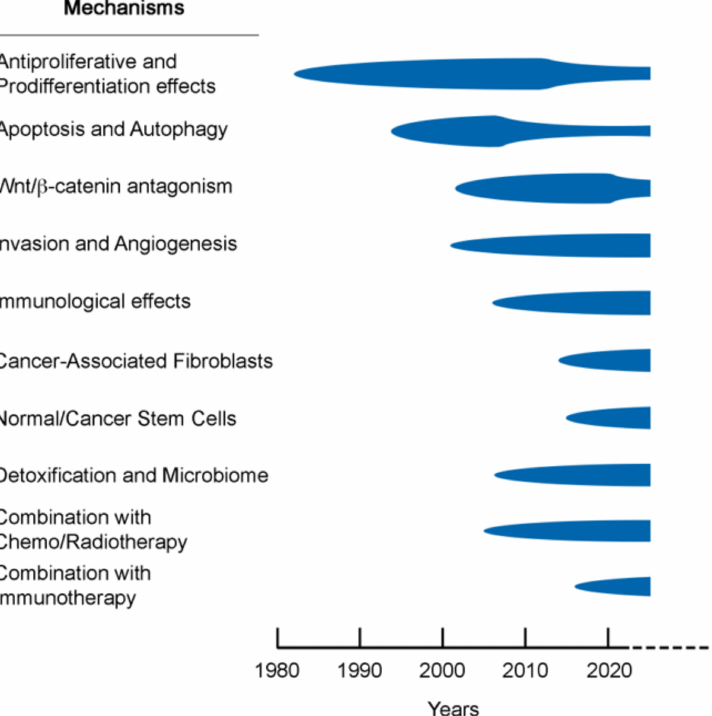
Figure 3. Time flow-chart of studies on the anticancer mechanisms of vitamin D compounds with some key references that are discussed in the